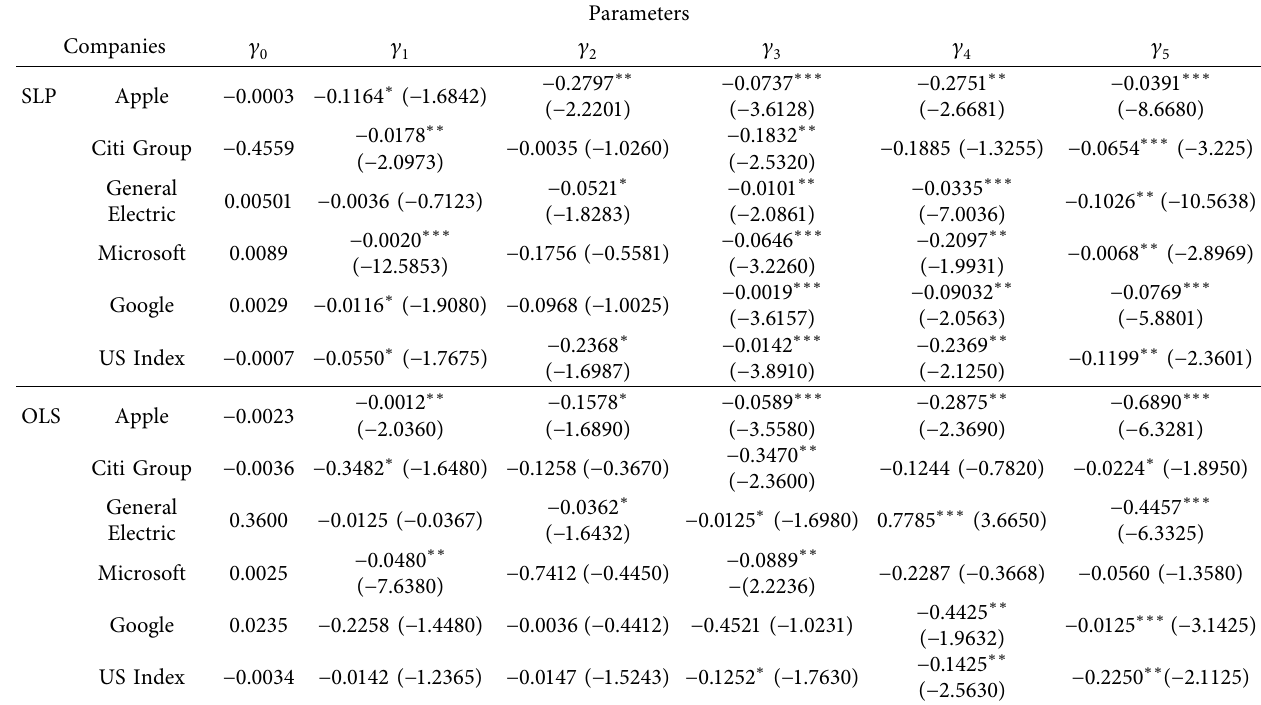
Table 7: Coefficient outputs for the US with